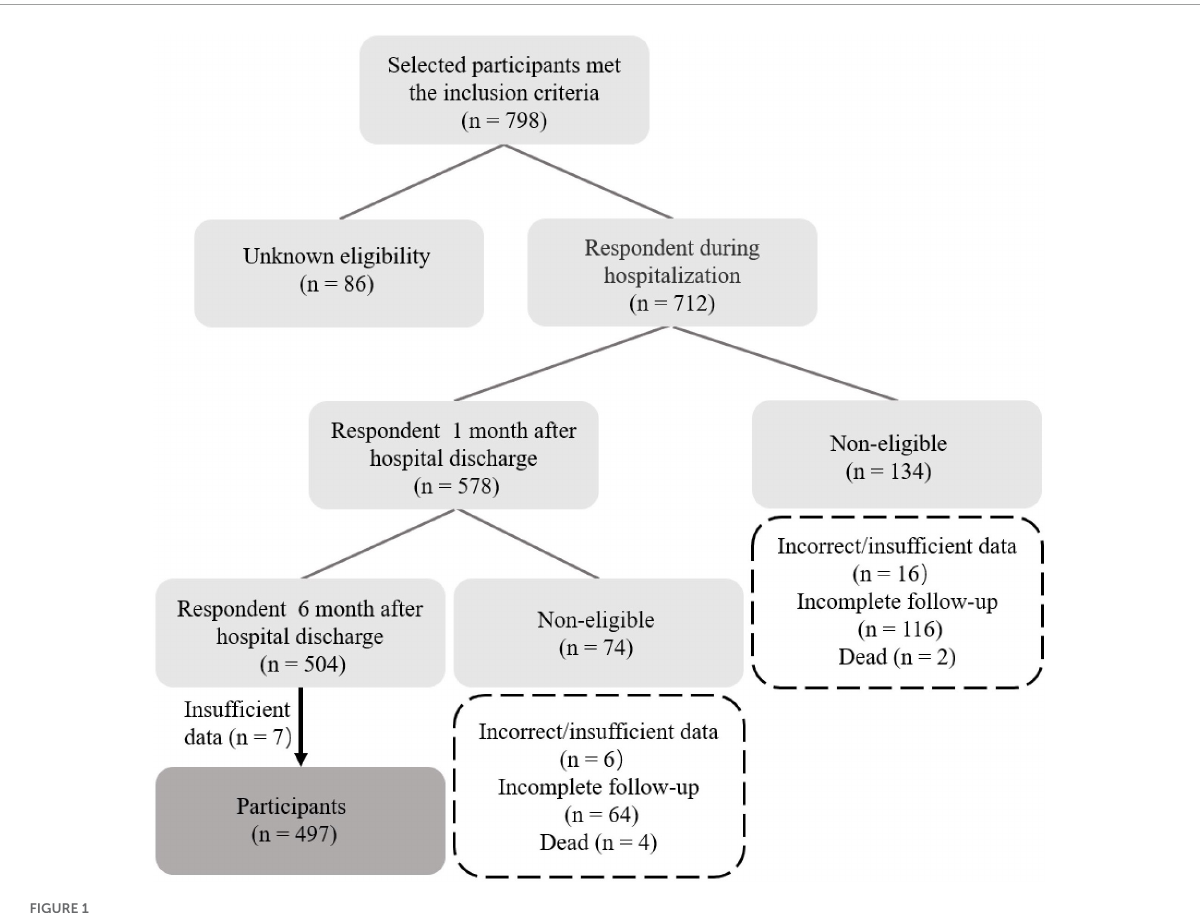
FIGURE1 Flowchart of participant’s